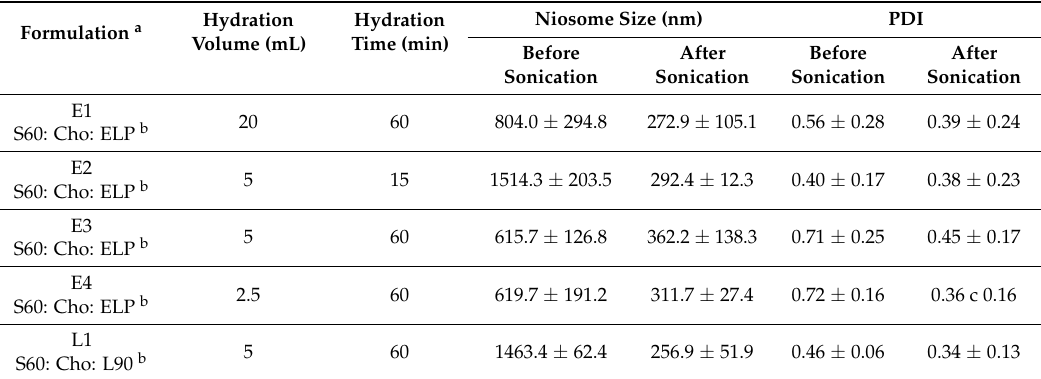
Table 1. Hydration volume (mL), hydration time (min), niosome size (nm) pre-sonication and post-sonication, and polydispersity index (PDI) pre-sonication and post-sonication of methylene blue-loaded niosomal formulations.